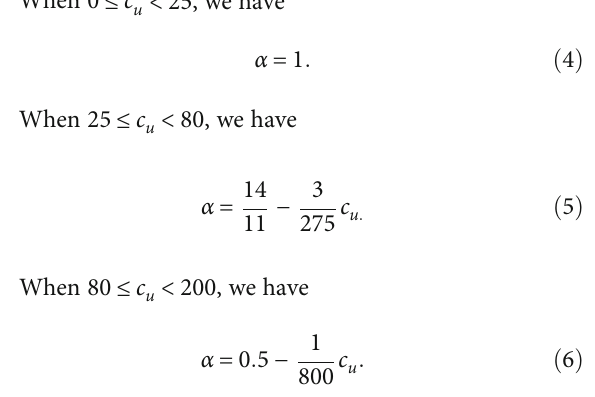
is the 1 is the upper 1